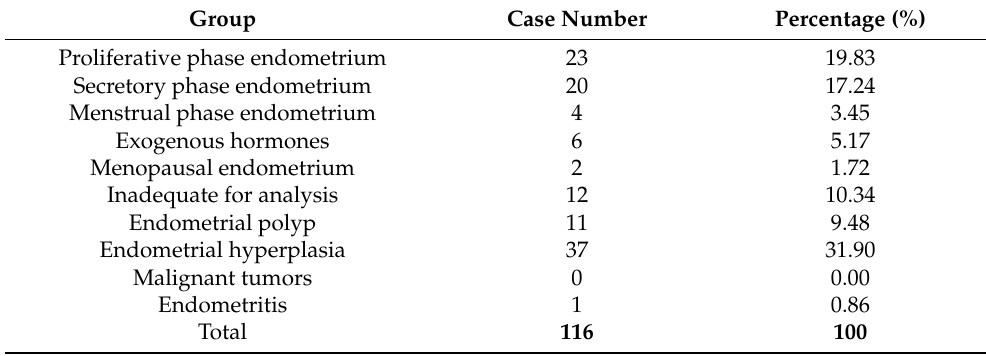
Table 10. Histopathological findings of clinically suitable samples extracted by scraping